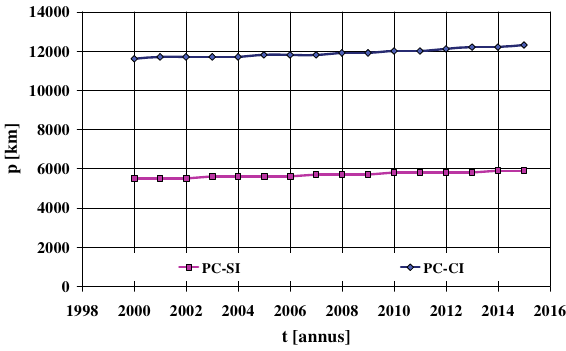
Fig. 2. Annual mileage of passenger cars with spark ignition- and compression ignition